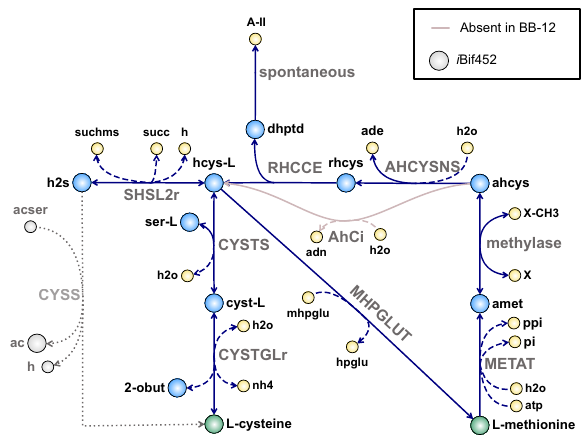
Fig. 6 Sulfur metabolism in BB-12 and BB-46. Either cysteine or methionine can serve as the sole amino acid and sulfur source for growth of BB-12 and BB-46. Methionine is proposed to be synthesized from cysteine through the irreversible conversion of homocysteine (hcys-L) to methionine (MHPGLUT). For the synthesis of cysteine from methionine, hcys-L might be formed through the sequential formation of S-adenoysl-L-methionine (amet), S- adenosyl-L-homocysteine (ahcys), and ribosylhomocysteine (rhcys). BB-46 possesses a gene encoding adenosylhomocysteinase (EC 3.3.1.1), which might alternatively convert ahcys in hcys-L (AhCi) directly. i AZ480 and i MS520 predicted that BB-12 and BB-46 can assimilate H 2 S through its incorporation into O-succinyl-L- homoserine to generate homocysteine (SHSL2r). Alternatively, the GEM of B. adolescentis L2-32 suggests H 2 S assimilation via the reaction of cysteine synthase (EC 2.5.1.47, CYSS), which lacks gene association and requires an additional non-gene-associated reaction to produce acetyl-serine (acser) 24 . Abbreviations of metabolite and reaction names are the same as used in the models (Supplementary Data 3 and